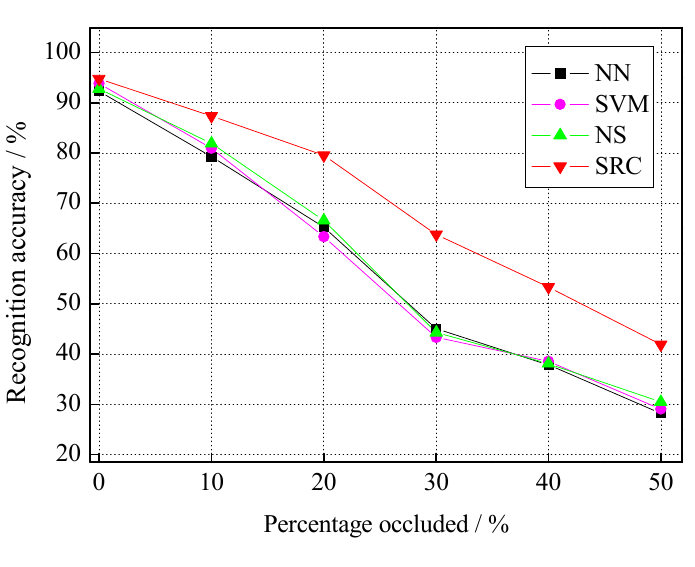
Figure 8. Recognition accuracy under different percentage